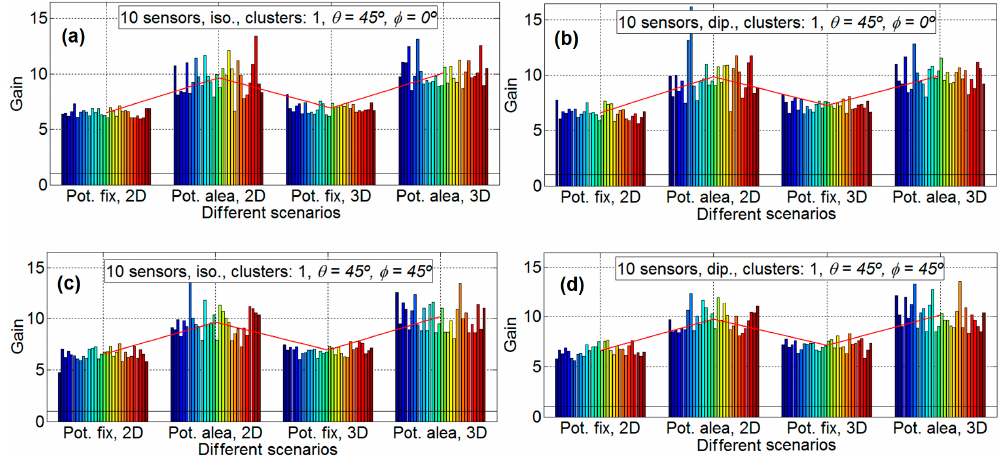
Figure 4. Gain results for 10 sensors. Isotropic ideal antenna, φ = 0 ◦ and θ = 45 ◦ in subfigure ( a ) ( upper left ), dipole antenna, φ = 0 ◦ and θ = 45 ◦ in subfigure ( b ) ( upper right ), isotropic ideal antenna, φ = 45 ◦ and θ = 45 ◦ in subfigure ( c ) ( lower left ) and dipole antenna, φ = 45 ◦ and θ = 45 ◦ in subfigure ( d ) ( lower right ).